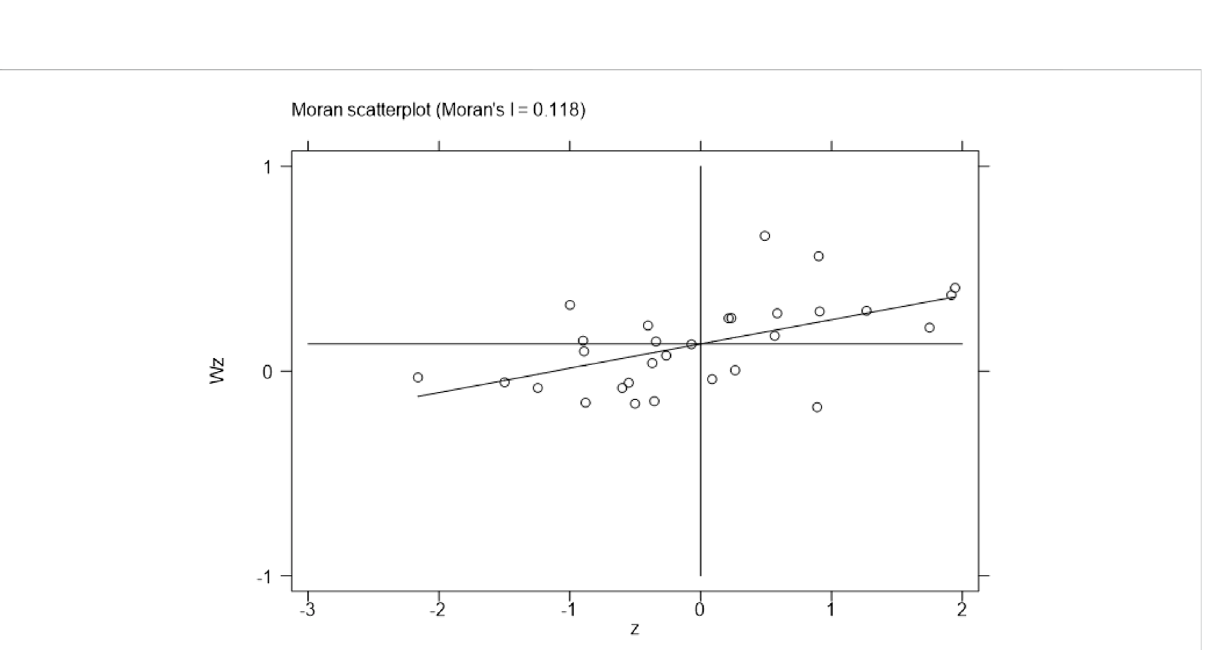
FIGURE 2 LISA map of regional atmospheric contamination in